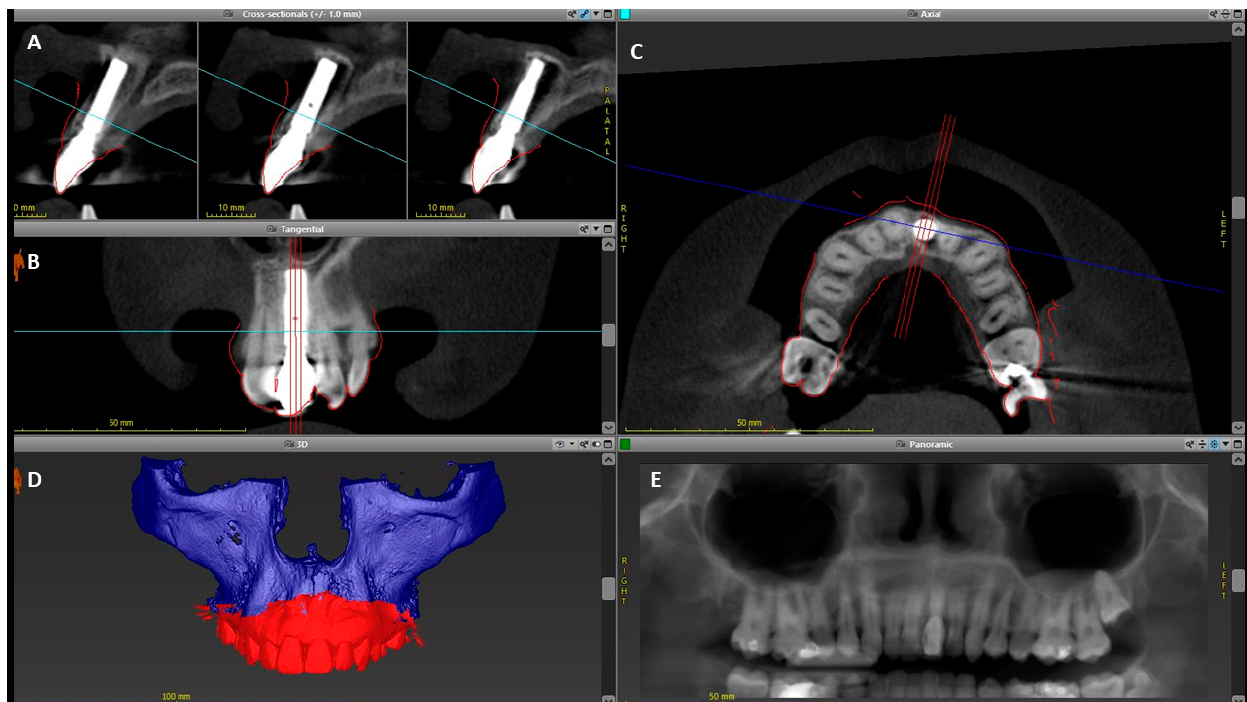
Table 2. Facial bone and soft tissue thickness (in mm) around implant at T5 time point. Figure 4. Working screen for the coDiagnostiX software. ( A ) Implant in cross ‐ sectional view, ( B ) Implant in tangential view, ( C ) Implant in axial view, ( D ) CBCT scan and intraoral digital scan from T5 imported and superimposed using coDiagnostiX software, ( E ) Reformatted panoramic view.